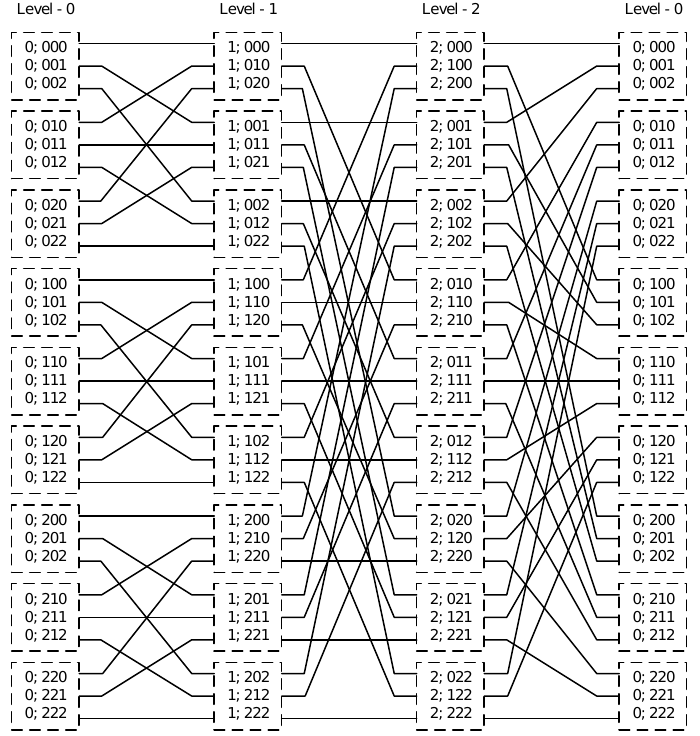
Figure 4. An instance of Generalized Hypercube Connected Cycle with parameters l = 3 and m = 3, i.e. GHCC (3,3)